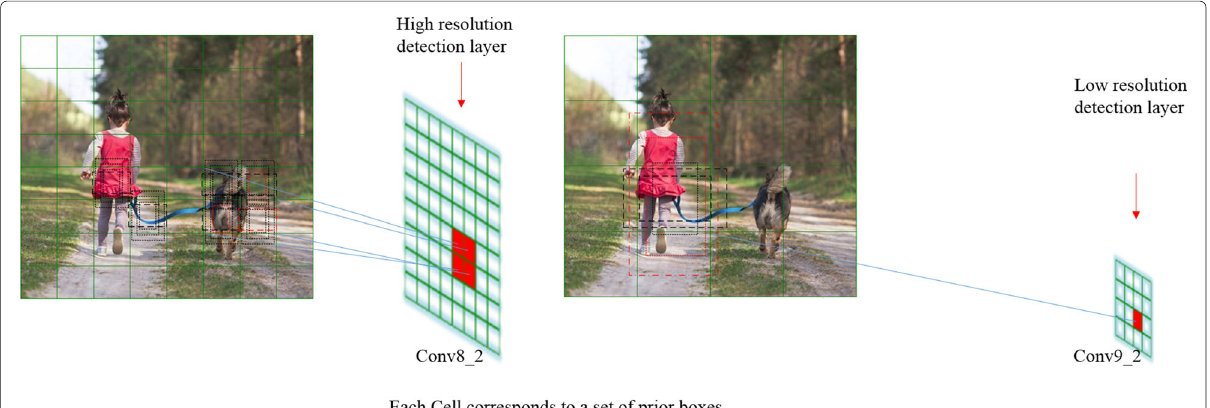
Fig. 6 Adaptive multi-resolution boundary box